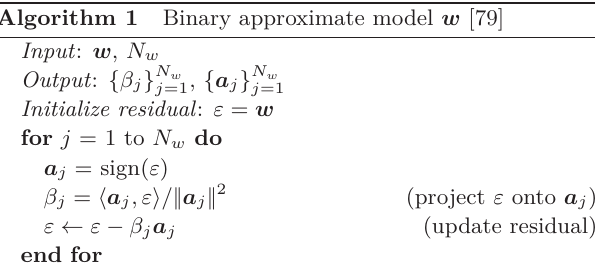
Algorithm 1 Binary approximate model w